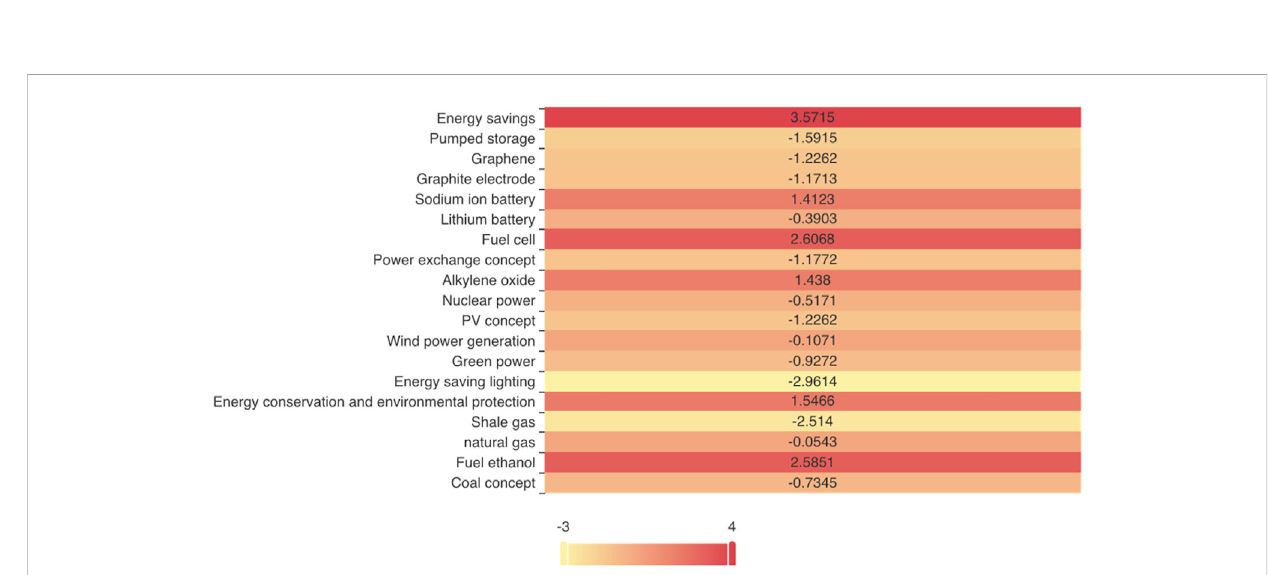
FIGURE 3 Scatter diagram of dimension reduction results of